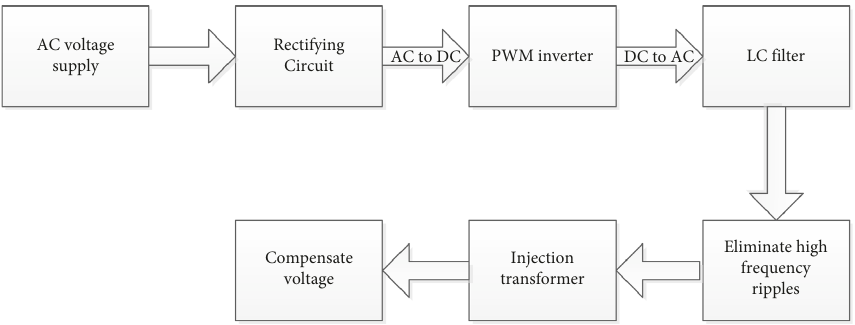
Figure 3: The flow chart of DVR